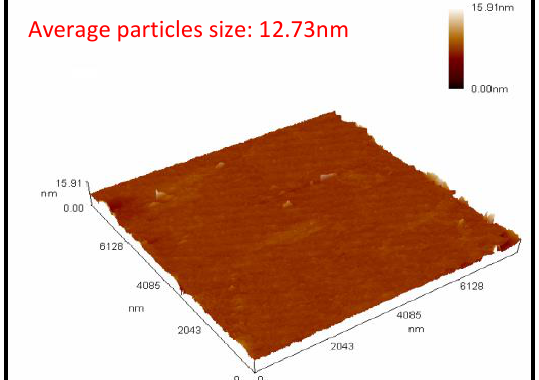
Average particles size: